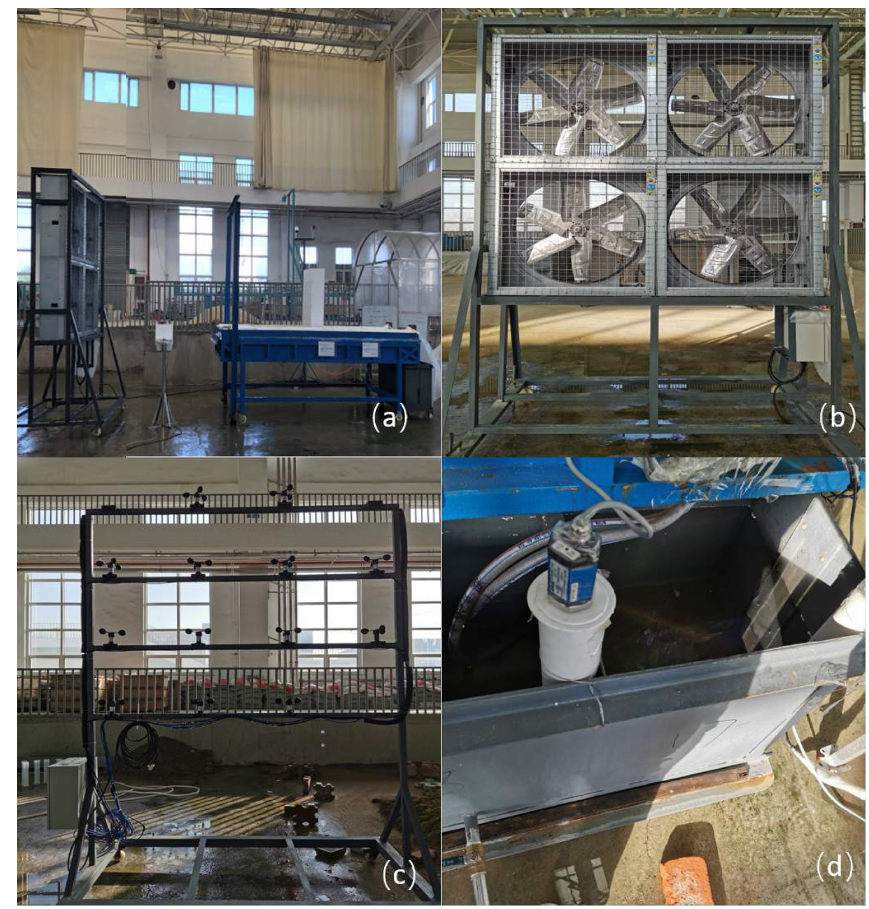
Figure 2. Laboratory apparatus. Panels (a–d) show the overall experimental device, the electric fan system, the wind-speed-measuring device, and the flow-measuring device,